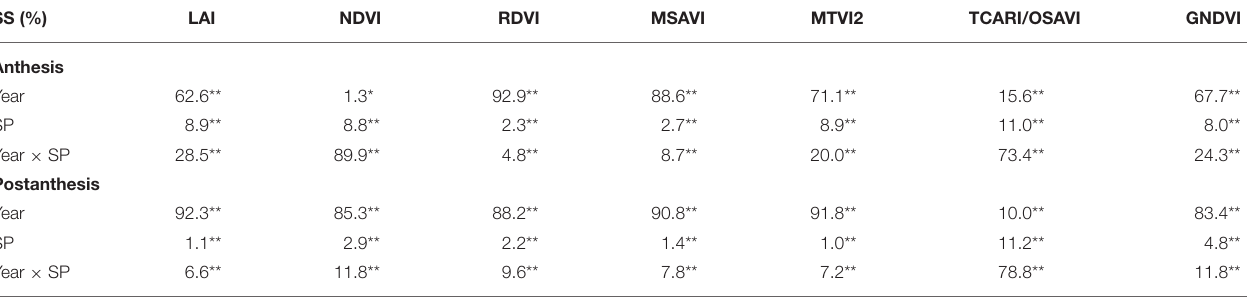
TABLE 4 | Analyses of variance for the LAI estimated through MTVI2 and all the VIs calculated at the anthesis (A) and postanthesis (PA) stages in 2017 and 2018. SS (%) LAI NDVI RDVI MSAVI MTVI2 TCARI/OSAVI GNDVI Anthesis